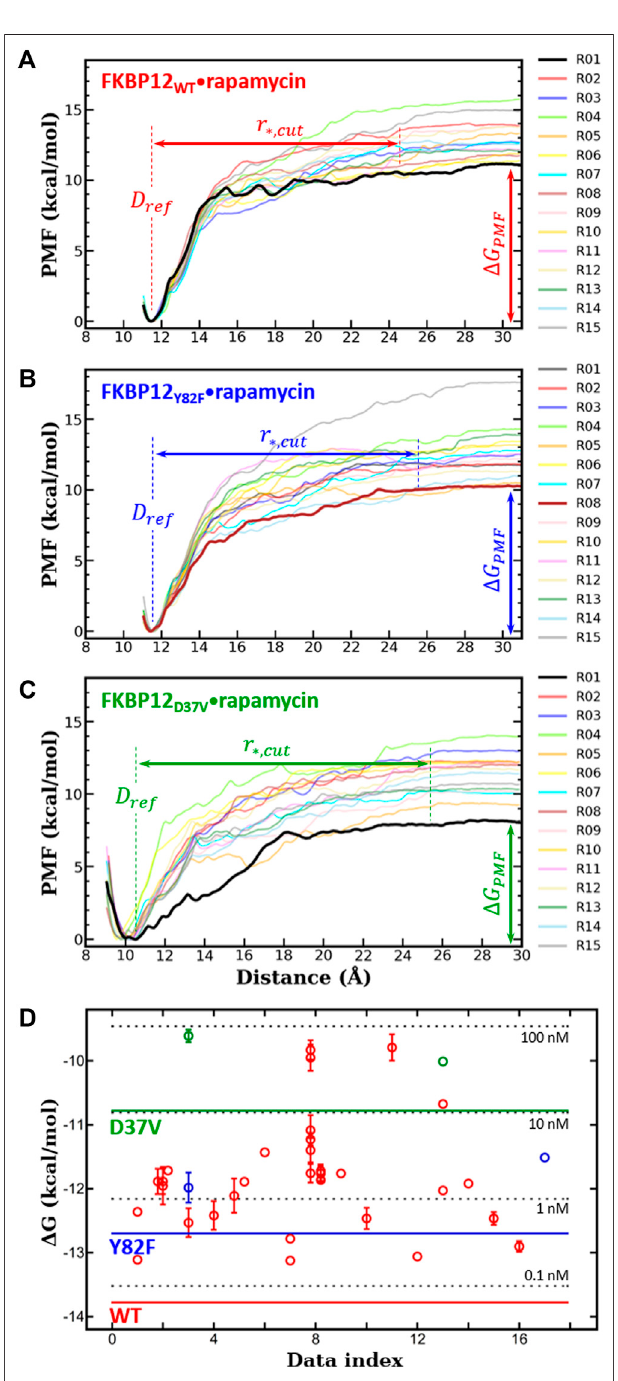
FIGURE 2 | In silico determination of the binding free energies for the three variants of FKBP12 + rapamycin % FKBP12 comparison with experimental data. (A) PMF pro fi les issued from the 15 runs of CPUS MD simulations performed on the FKBP12 WT complex at T sim = 21.85 ° C. The lower-bound PMF pro fi le is highlighted in bold, and snapshots taken during this particular dissociation process are displayedin SupplementaryFigureS3 .Furthermore,wehaveindicatedwith double-headed arrows the associated cutoff separation distance, r p , cut , and binding free energy, Δ G PMF (see Supplementary Table S1 for all 15